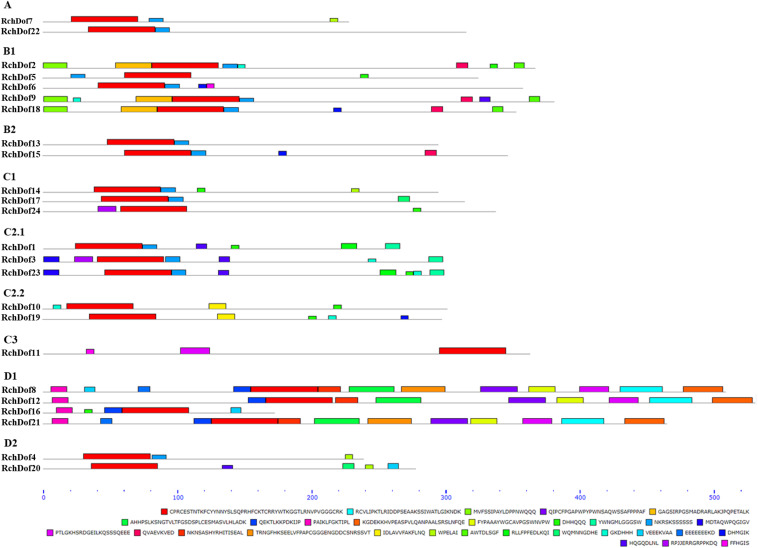
Conserved motif compositions of the RchDof gene family. The conserved motifs were detected using MEME software and represented by colored boxes. The length of RchDof proteins can be estimated using the scale at the bottom, and the conserved motifs are shown in Table 1.